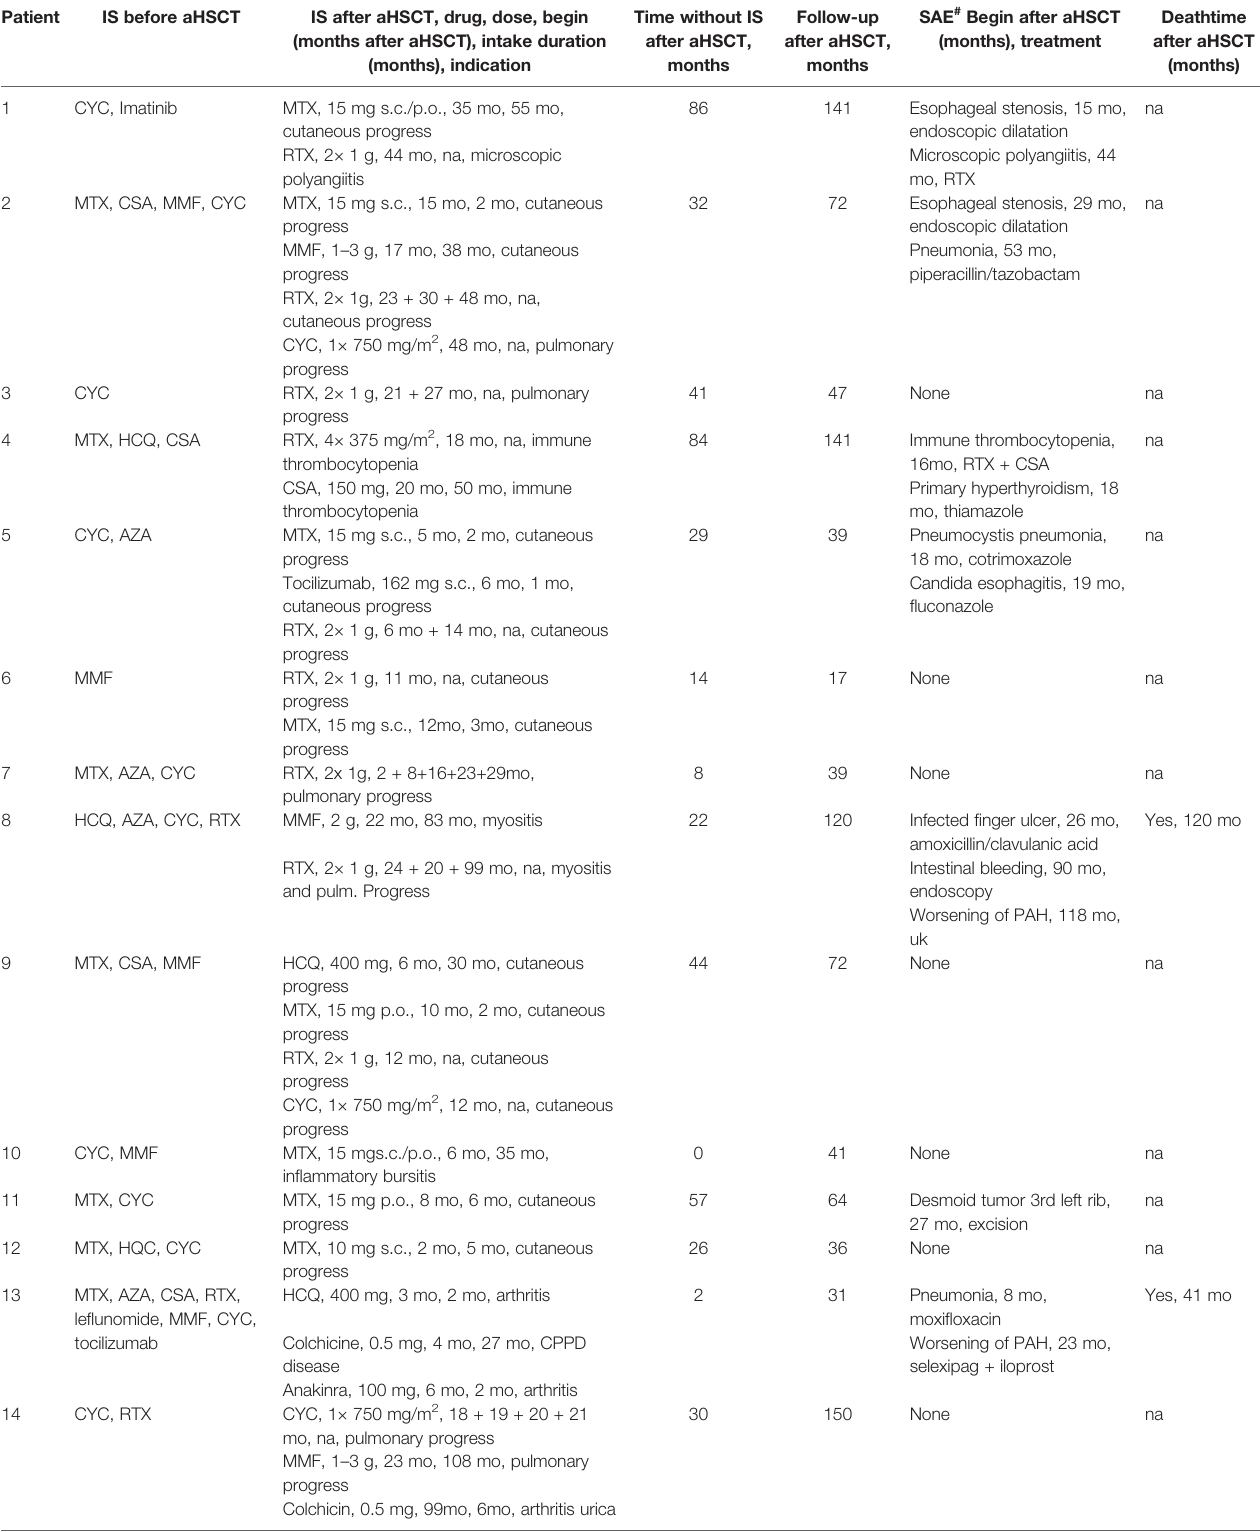
TABLE 2 | Immunosuppression (IS; without glucocorticoids) and severe adverse events (SAEs) after aHSCT.